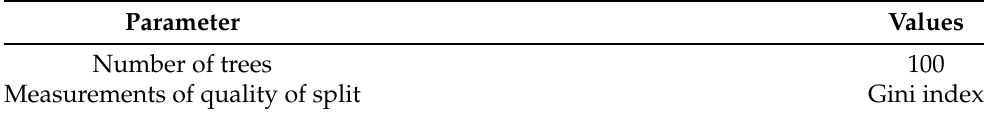
Table A4. Parameters of the random forest